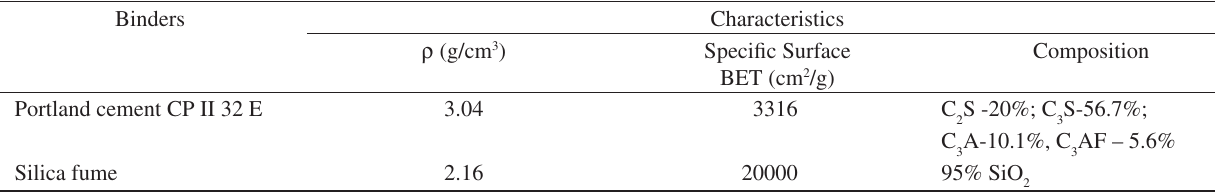
Table 1. Characteristics of the binders used for the concrete studied.